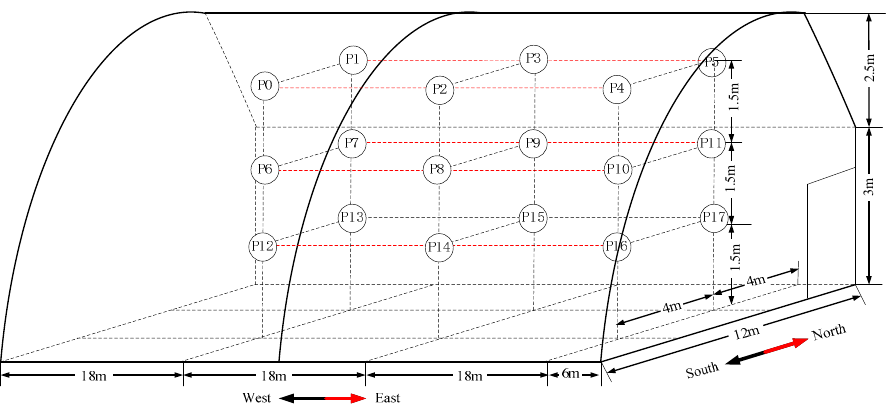
Figure 2. Distribution diagram of environmental sensors.